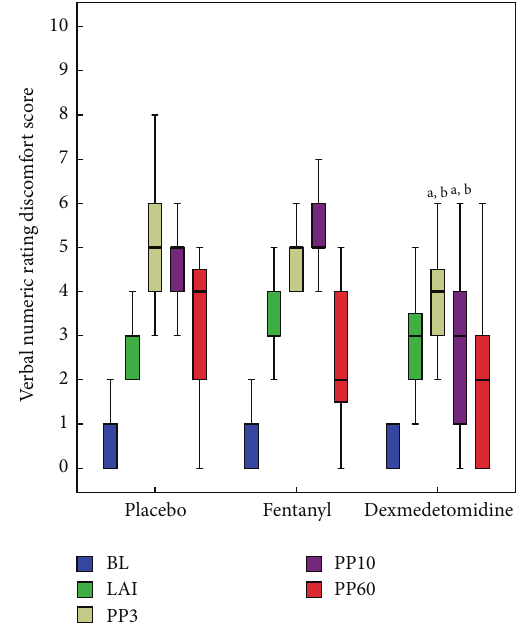
Figure 3: Box plots of perceived discomfort score during the study period showing median and interquartile range (25–75). BL, before starting study drug infusion; LAI, after initial LA injection; PP3, immediately after the CVCI, the patient was asked to report the peak pain experienced during the procedure; PP10, 10min after completion of the procedure; and PP60, 60min after completion of the procedure. a 𝑃 < 0.016 versus placebo; b 𝑃 < 0.016 versus fentanyl.